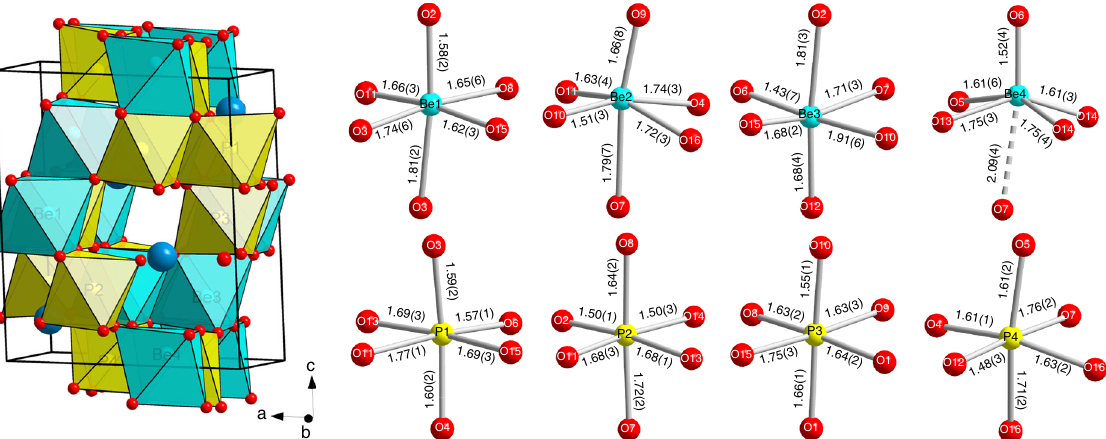
Fig. 4 The crystal structure of hurlbutite-IV at 89.5(1) GPa. PO 6 octahedra are given in yellow, BeO n polyhedra are given in light blue. Ca and O atoms are presented as blue and red spheres